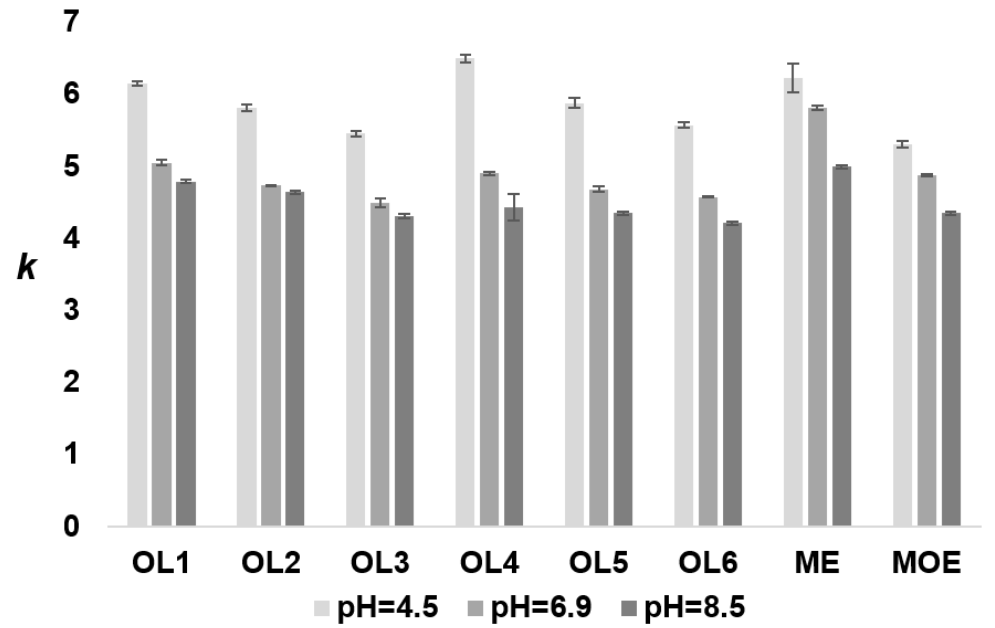
Figure 2. The impact of sodium chloride pH on the oligonucleotides’ retention. Experimental conditions: stationary phase with III dendrimer layers; gradient elution program: 0 min. — 0.125 M NaCl, 5 min. — 0.4 M NaCl, 15 min. — 0.4 M NaCl; flow rate 0.3 mL/min; autosampler and column temperature: 35 °C; injection volume: 1 µL; detection UV at λ = 260 nm.